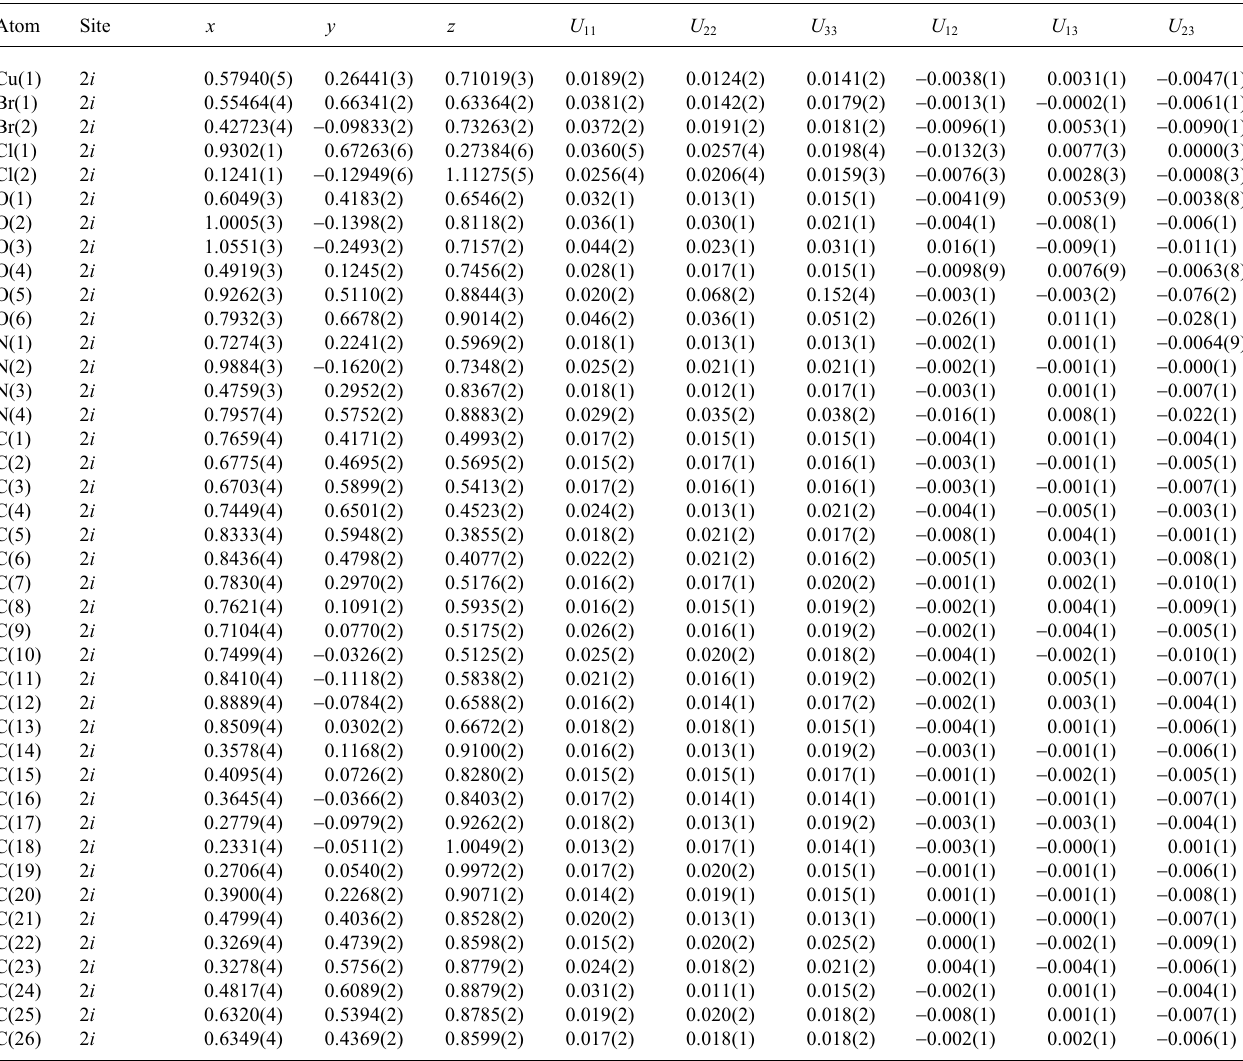
Table 3. Atomic coordinates and displacement parameters (in Å 2